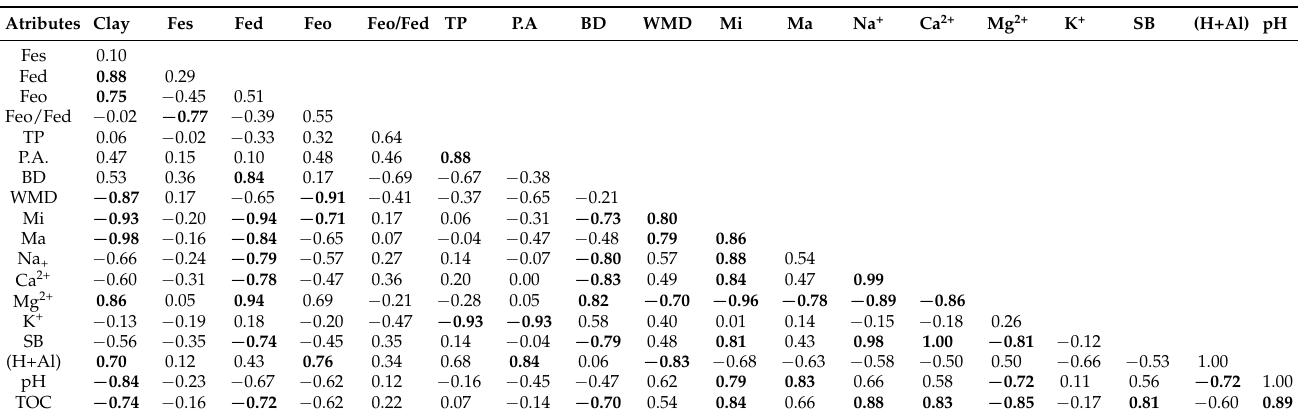
Table 6. Correlation matrix between the variables of physical, chemical and mineralogical attributes of the studied